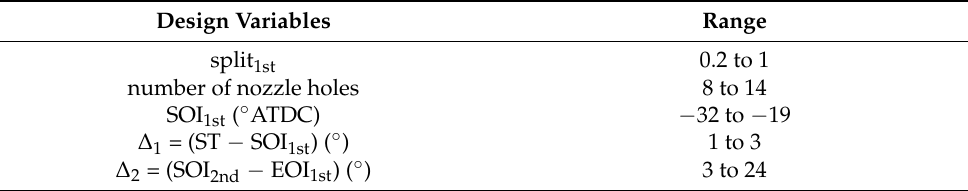
Table 5. Design variables and ranges for DoE.